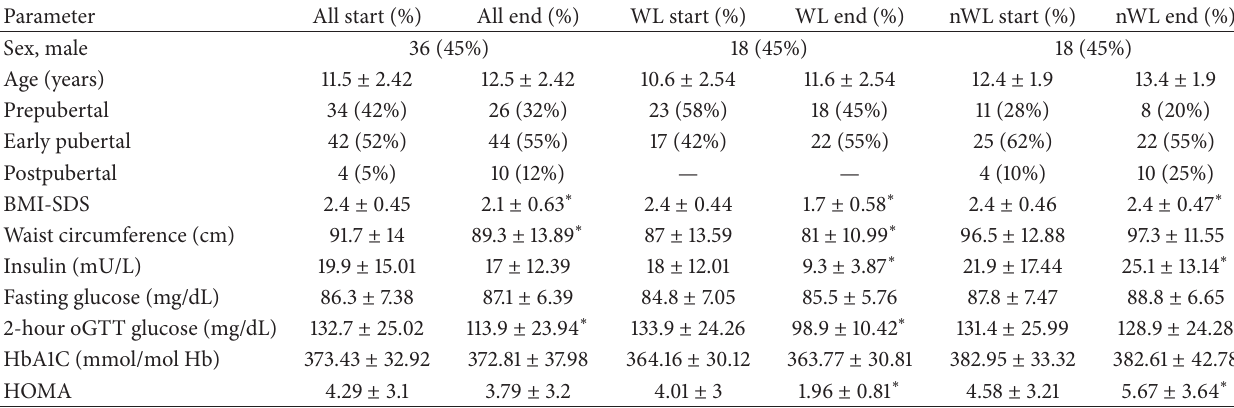
Table 1: Characteristics of participating children at start and end point of the 1-year intervention period. Characteristics are shown for all obese children ( 𝑛 = 80 ), children with substantial weight loss (WL, 𝑛 = 40 ), and children without substantial weight loss (nWL, 𝑛 = 40 ) as mean ± SD unless stated